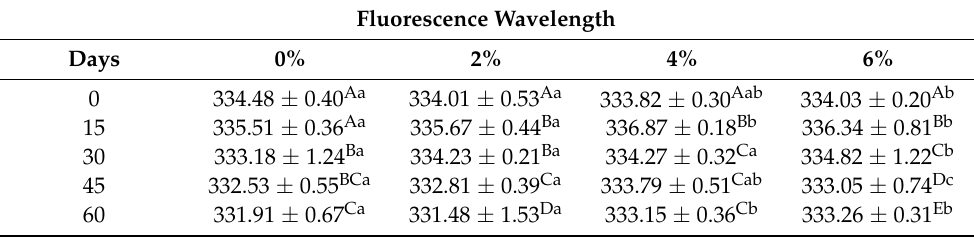
Table 3. Fluorescence wavelength of myofibrillar proteins treated with different concentrations of OVA-KC during 60 days of frozen storage at − 18 ◦